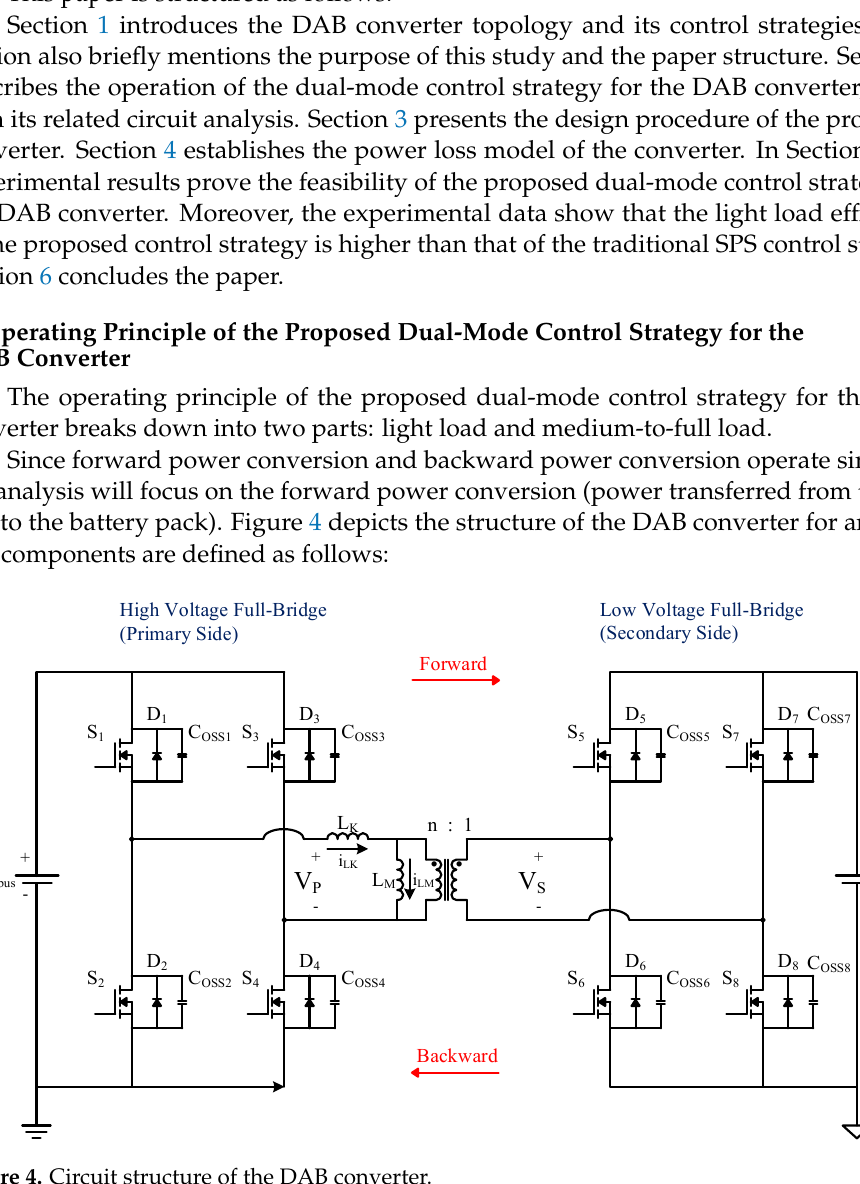
t 7 t 8 Figure 5. Theoretical waveforms of the proposed control strategy for the DAB converter in PWM mode under light load conditions. State 1 ( t 0 ≤ t ≤ t 1 ): As shown in Figure 5, due to the discharge of energy stored in C OSS1 , C OSS4 , C OSS5 , and C OSS8 to zero during the dead time in the previous state, switches S 1 , S 4 , S 5 , and S 8 are